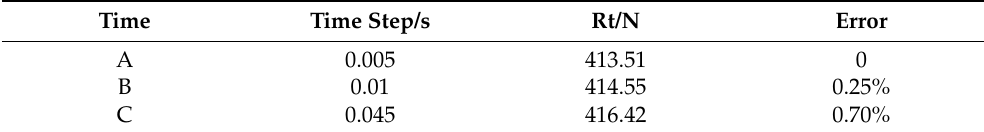
Table 4. Time step